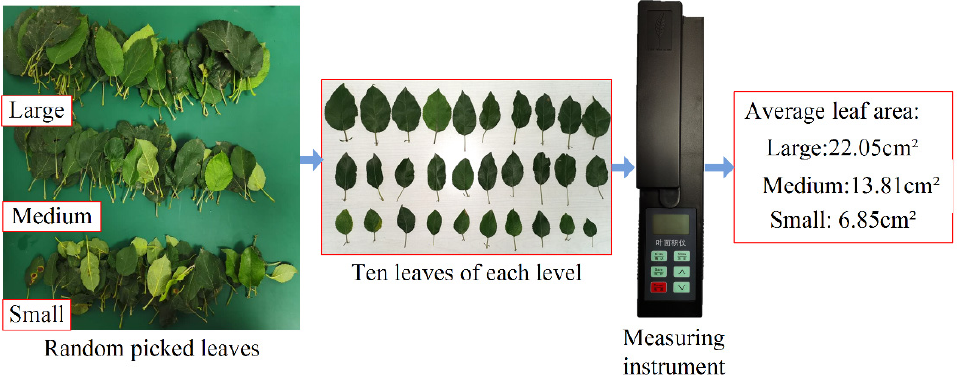
Figure 3. Leaf area measurement using statistical analysis.